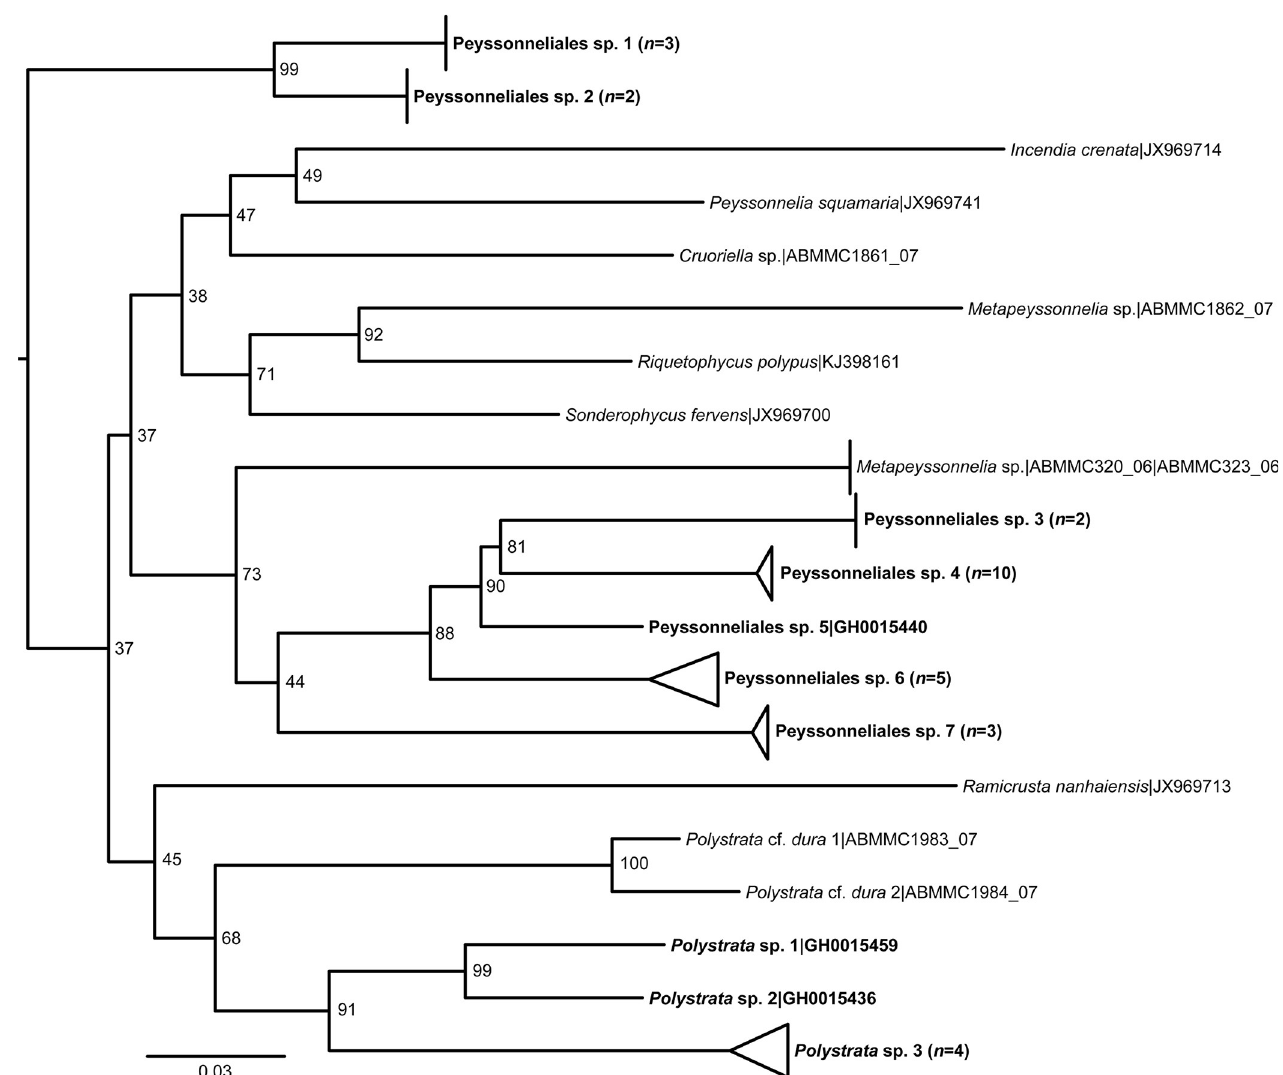
Fig 3. Maximum likelihood phylogeny of the 10 Peyssonneliales species (boldface font) from the recruitment tiles and 10 reference sequences from GenBank inferred from COI-5P sequences. The tree was inferred by maximum likelihood with IQ-TREE [65]. Support values listed next to each node are ultrafast bootstrap approximations based on 1000 replicates. Scale bar represents nucleotide substitutions per site.